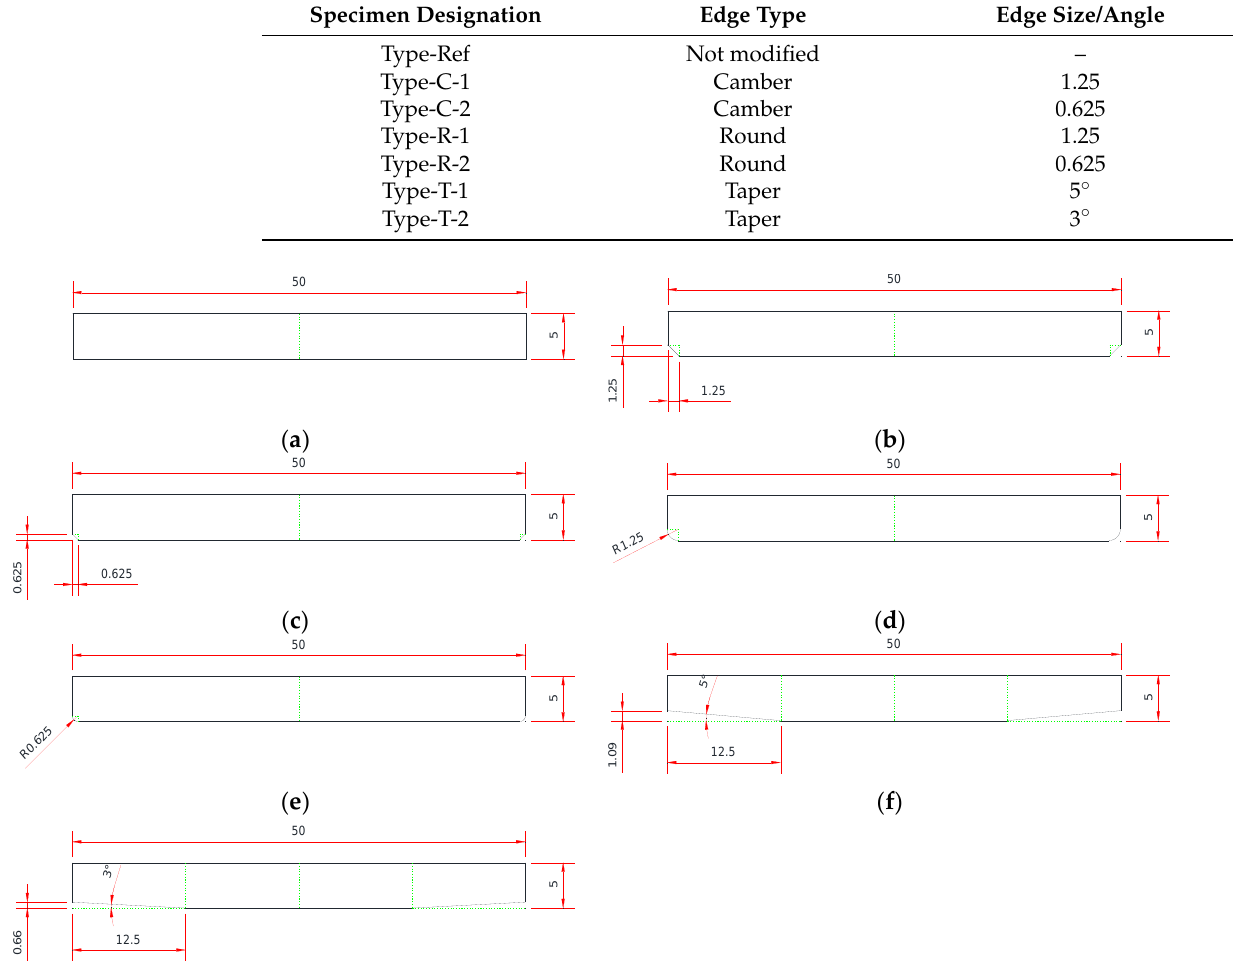
Table 3. Designation and characteristics of specimens.